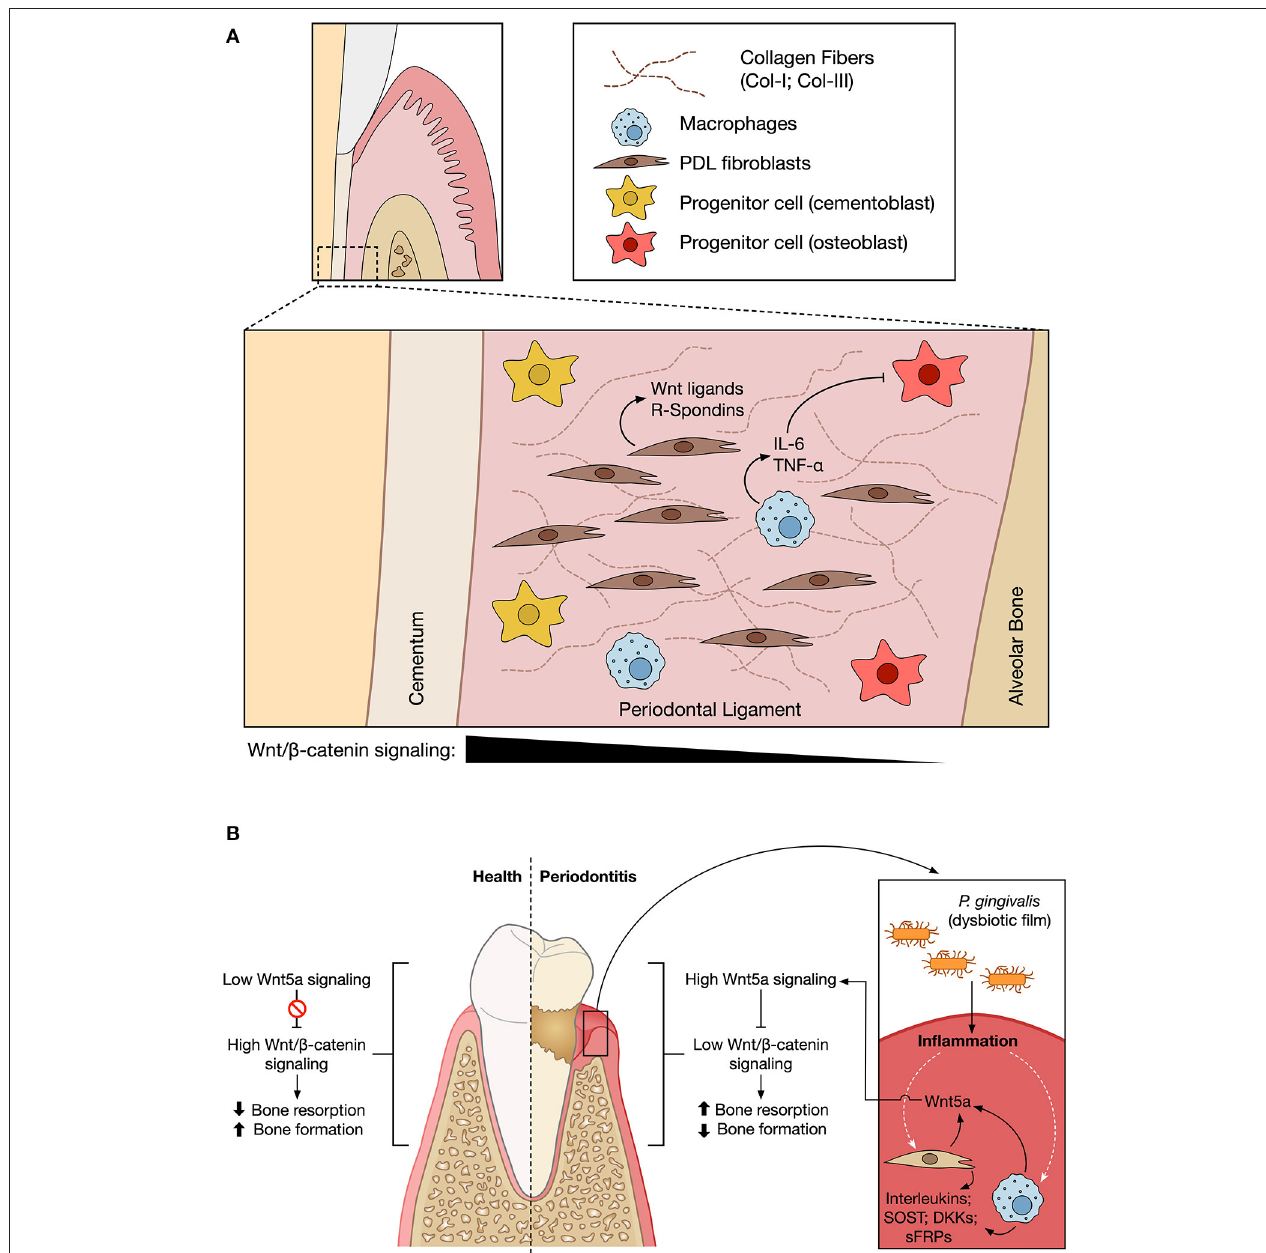
FIGURE 2 | Wnt signaling in periodontium maintenance and periodontitis. (A) The different cellular components of the periodontal ligament (PDL) are embedded in a rich extracellular matrix composed of Collagen I (Col-I) and III (Col-III) fibers. Studies performed in animal models suggest the existence of a gradient of Wnt/ β -catenin activity across the PDL (black triangle), with higher levels of osteogenic differentiation in areas closer to the alveolar bone. Macrophages within the PDL might secrete factors such as IL-6 or TNF- α , which might inhibit the osteogenic differentiation of resident cells in the context of periodontal disease. Secretion of Wnt5a and R-Spondins has also been reported. For simplicity, only the indicated cellular types are shown. (B) In a healthy context, the Wnt/ β -catenin pathway might have a crucial role in the homeostasis of the PDL and the maintenance of the bone and cementum. However, the challenge mediated by periodontopathic bacteria might promote the local production of Wnt5a, which in turn might contribute to sustaining an inflammatory loop due to its ability to induce the expression of MCP-1, thus promoting the recruitment of macrophages. This can contribute to an imbalance between the Wnt pathway branches, favoring the non-canonical Wnt pathway. Wnt5a might thus promote bone tissue loss, decreasing tooth insertion. P. gingivalis might also induce JAK3 phosphorylation and increased Wnt3a levels (not shown), in turn reducing inflammation. The physiological outcome might thus depend on the relative balance of secreted cytokines and Wnt modulators. Figures based on work created with